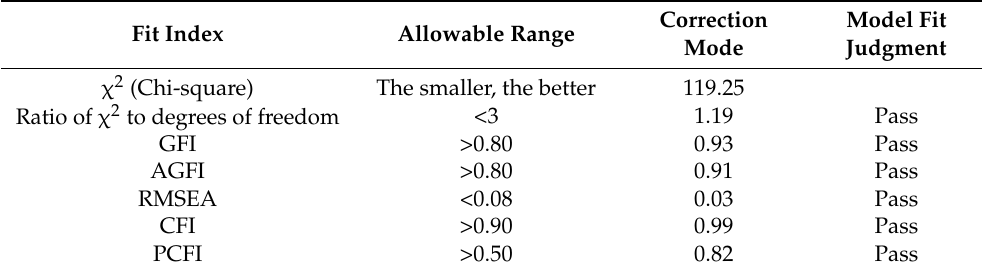
Table 7. Analysis of the overall model